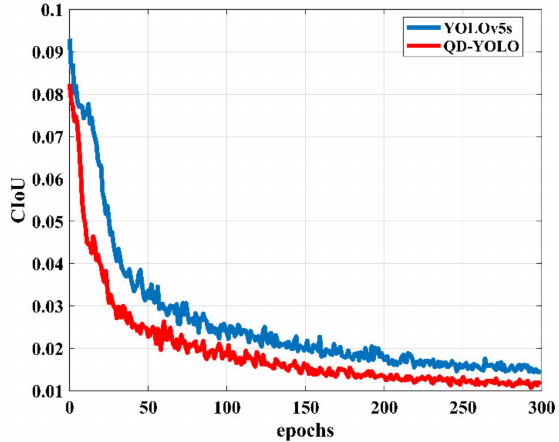
Figure 7. Comparison of CIoU values in network training before and after improvement.